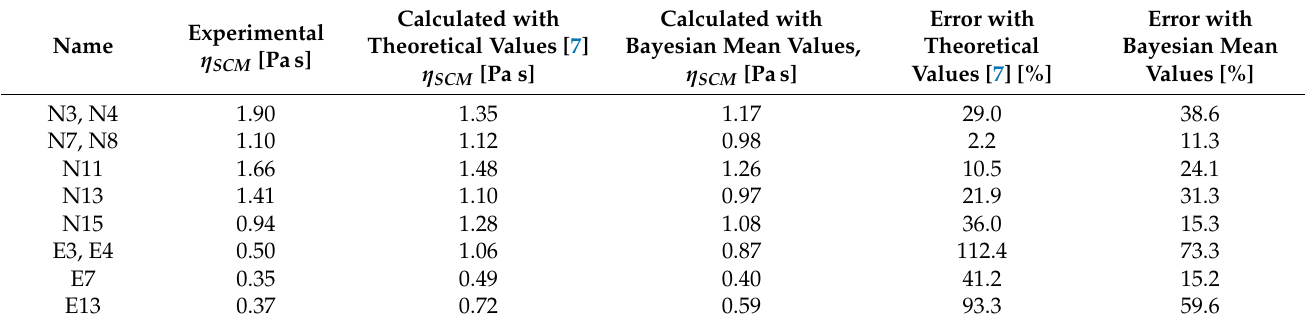
Table 6. Comparison between experimental values and model results for self-compacting mortar (Ouro et al. [38]).